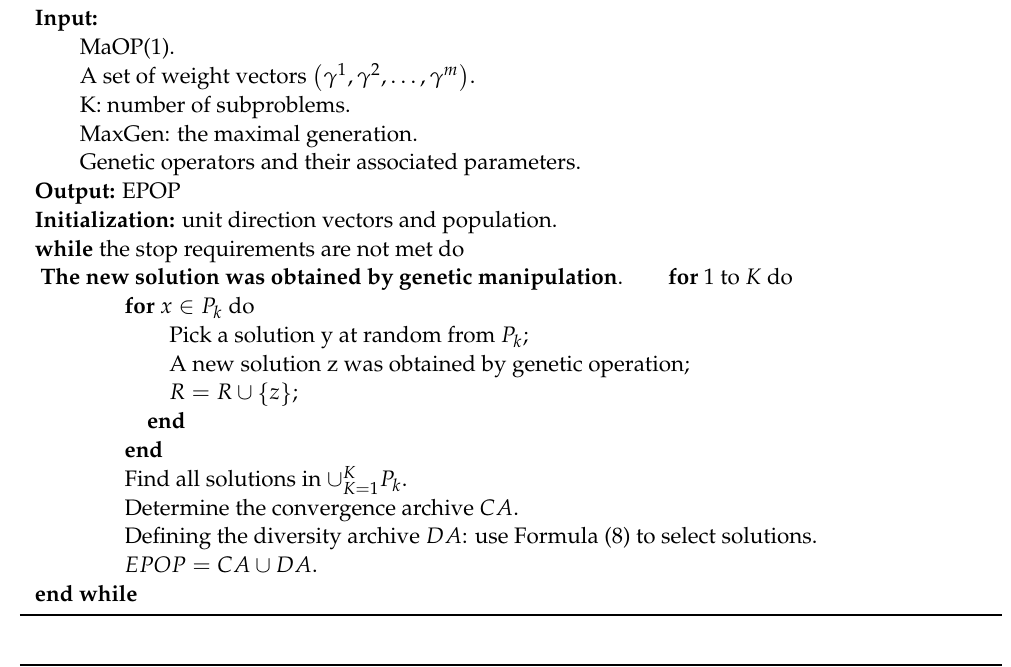
Algorithm 1: Proposed algorithm framework